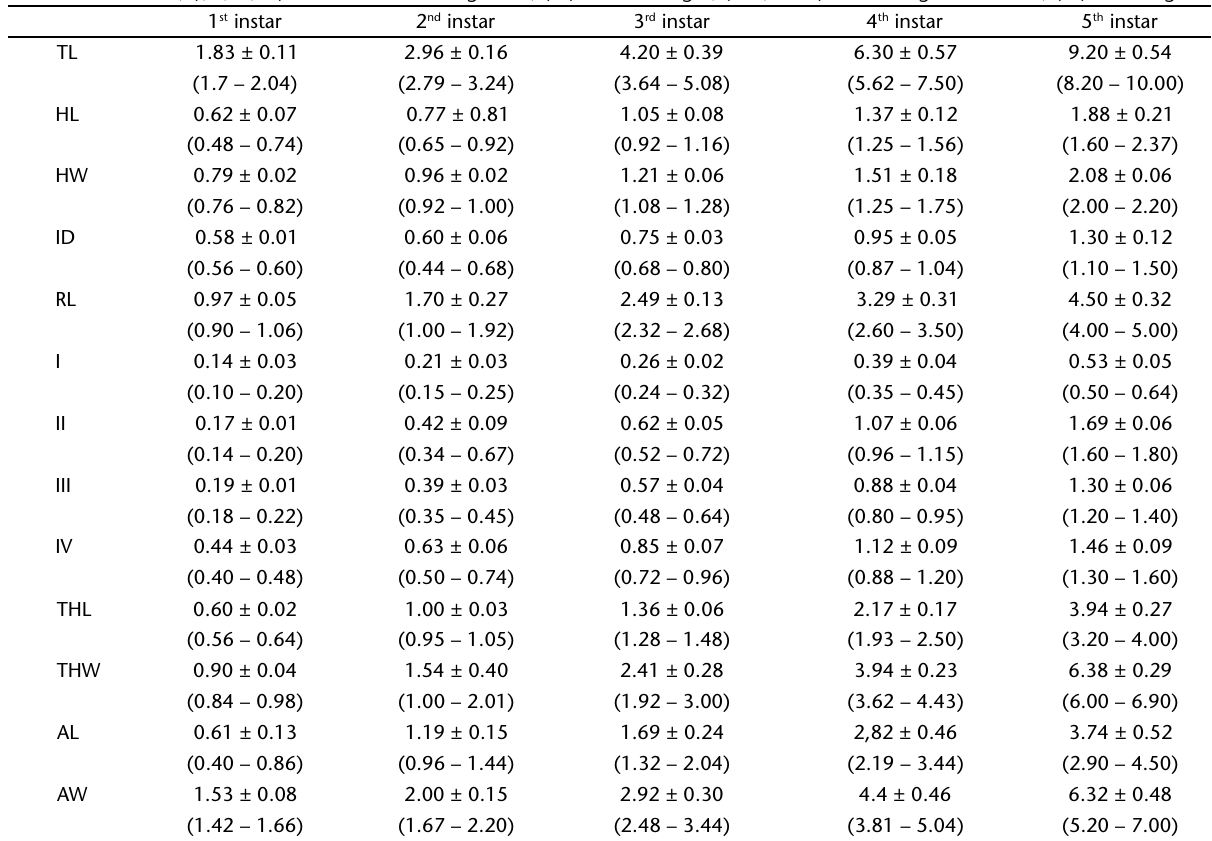
Table I. Measurements in millimeters (mean ± deviation, minimum – maximum, n = 10) of morphometric parameters of nymphs of Euschistus (Mitripus) grandis reared under controlled conditions. (AL, AW) Abdominal length and width, (HL, HW) head length and width, (ID) interocular distance, (I, II, III, IV) 1 st to 4 th antennal segments, (RL) rostrum length, (THL, THW) thorax length and width, (TL) total